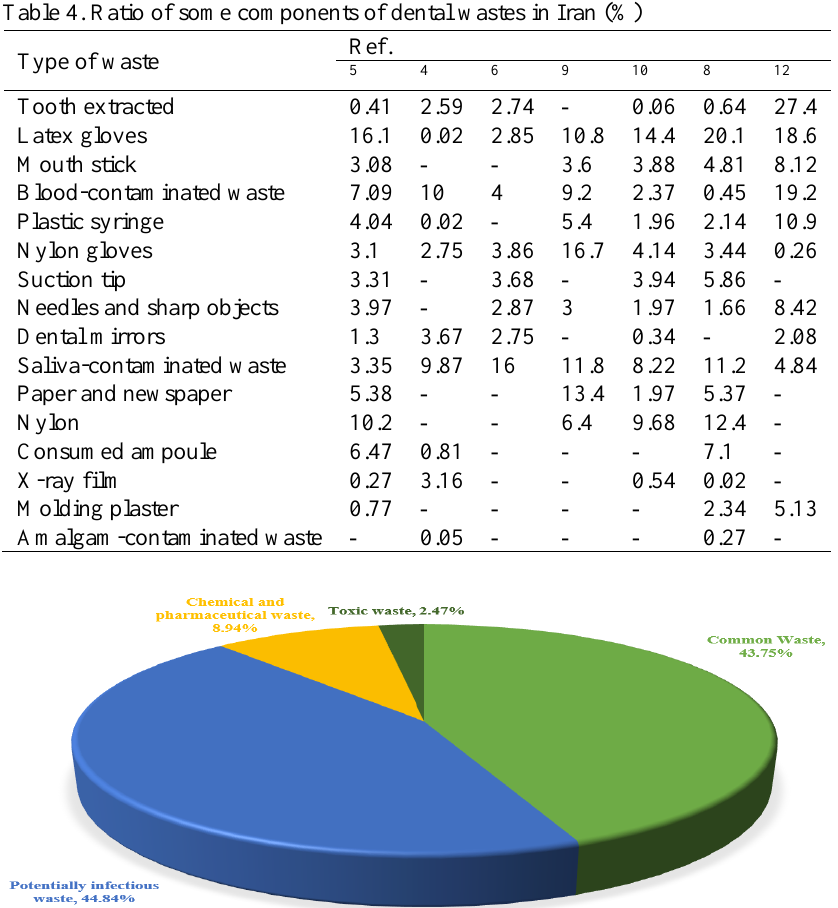
Fig. 3. Different ratios of dental waste components in Iran based on reviewed